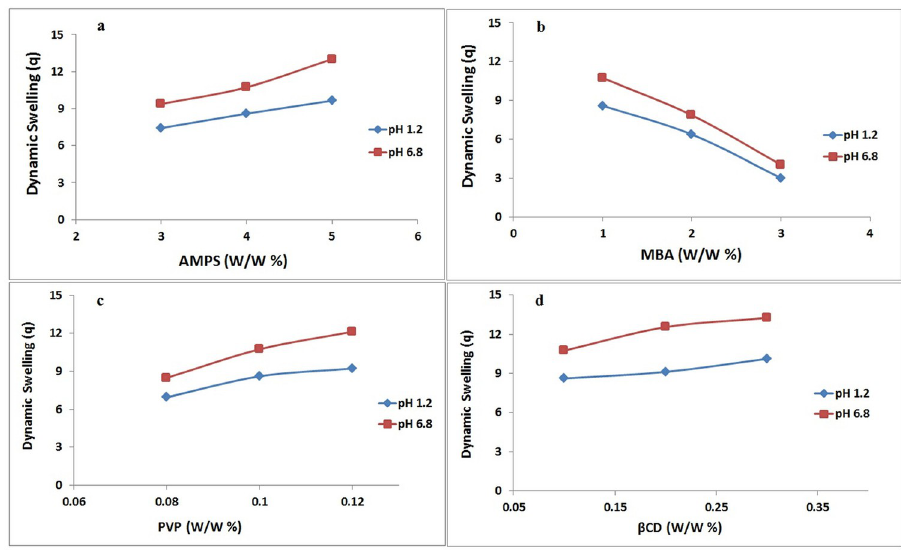
Fig 7. Effect of different concentrations of AMPS (a) MBA (b) PVP (c) and β CD on swelling index at pH 1.2 and pH 6.8 indicating all components have an incremental effect on swelling except MBA having the opposite effect.